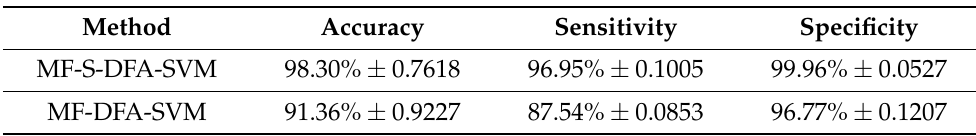
Table 4. Classification evaluation metrics for MF-S-DFA-SVM and MF-DFA-SVM: accuracy, sensitivity and